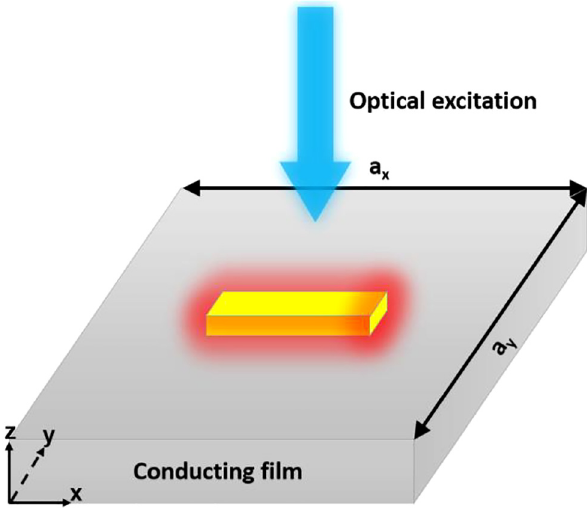
Figure 2: Schematic of plasmonic heating effect. An excited plasmonicnanoparticleiscenteredonasubstratewithpitchperiods being denoted as a x and a y . Note that a x and a y are in fi nite for nanoparticle on fi lm system and fi nite values for particle-array-on- fi lm system. Here the nanoparticle is only represented by a yellow nanoscale cut wire (CW), while other nanostructures are not